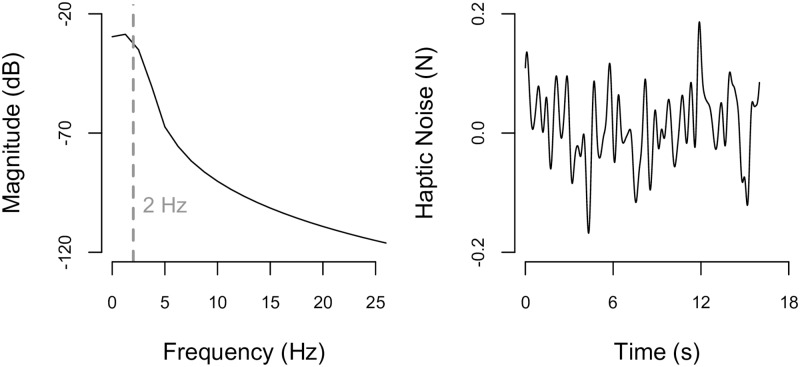
Haptically rendered noise.(Left) An example of the haptically rendered noise, HRN, power spectral density is given by the black solid line, and the low-pass filter cut-off frequency of 2 Hz is indicated by the gray dashed vertical line. The power spectral density was obtained using Welch’s averaged modified periodogram method of spectral estimation function in MathWorks’ Matlab (Massachusetts, United States), pwelch(). (Right) HRN is plotted as a function of time.